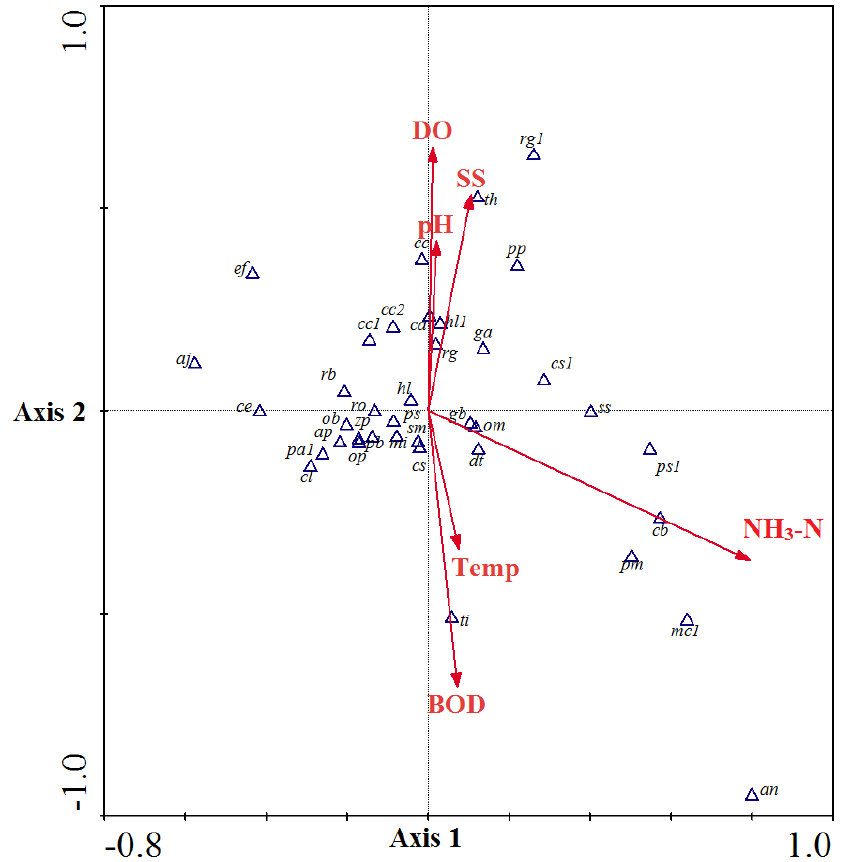
Figure 4. The environmental factors loading and their correlation to fish taxa of the Tanshui River system. Sampling sites located in upstream area were not affected by tidal movement in 2012. Plot based on the regression on factors 1 and 2. The abbreviations used in this picture are listed in Table